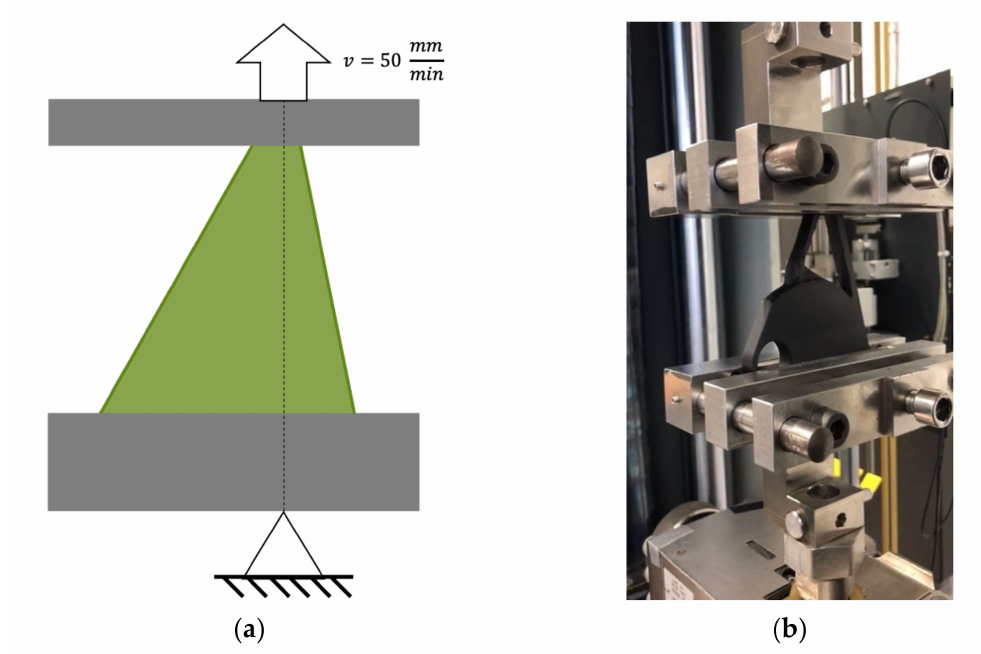
Figure 10. Experimental set-up: ( a ) sketch; and ( b ) actual experimental